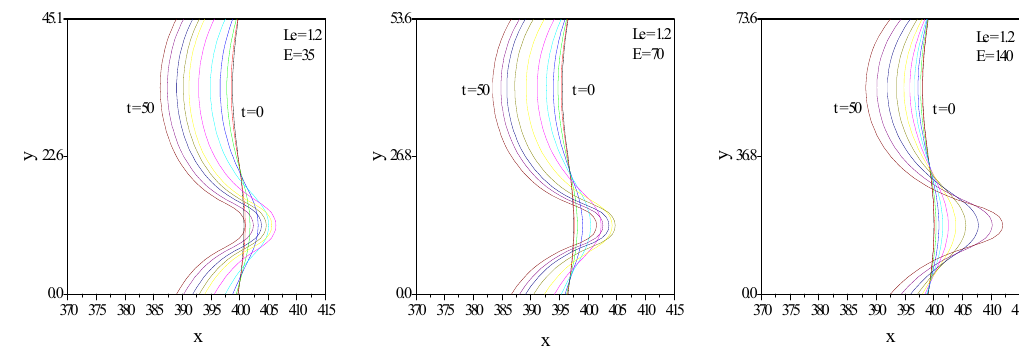
Fig. 9. The evolution of cellular fronts at Le = 1.2 and E = 35, 70 and 140 in adiabatic flames ( t = 0, 5, 10, . . . ,